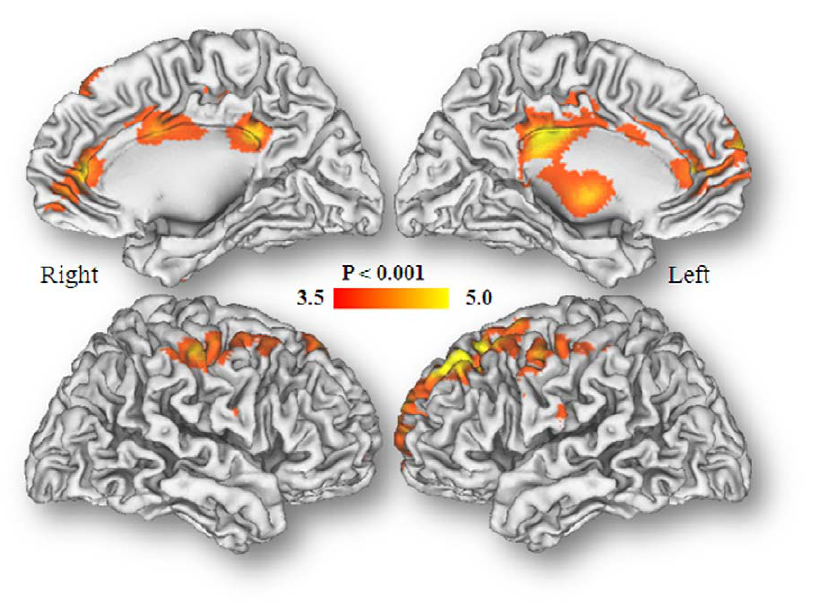
Figure 2. SPM results for the gender by cues (Neutral . Cocaine-cues) interaction on the ‘‘normalized’’ metabolic images. Comparison correspond to Females . Males for uncorrected threshold p u , 0.001 cluster . 200 voxels. There were no regions where males had larger changes than females.